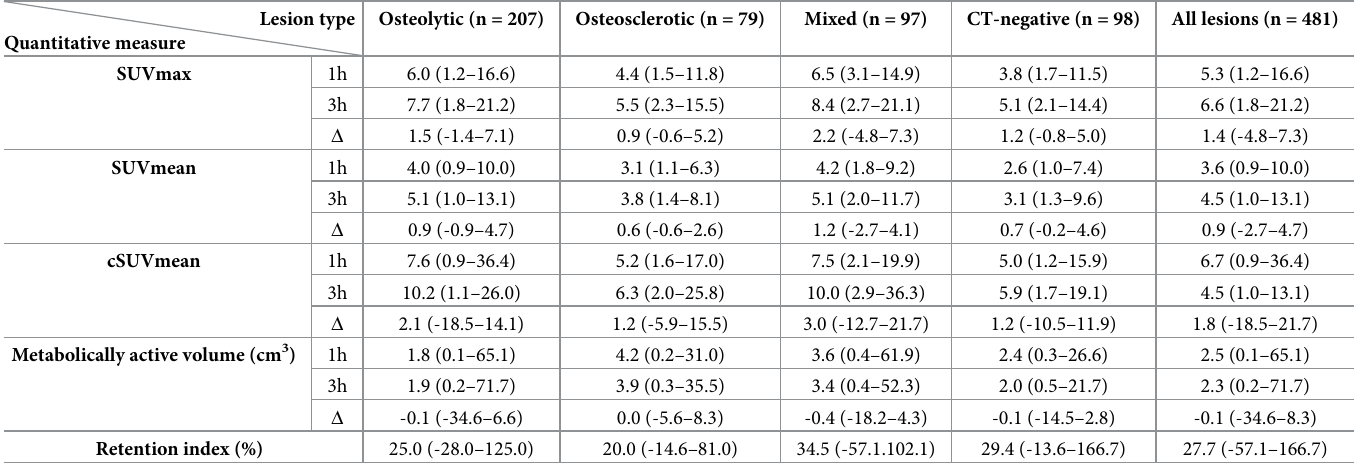
Table 3. FDG uptake and metabolically active volume in types of bone metastasis � .